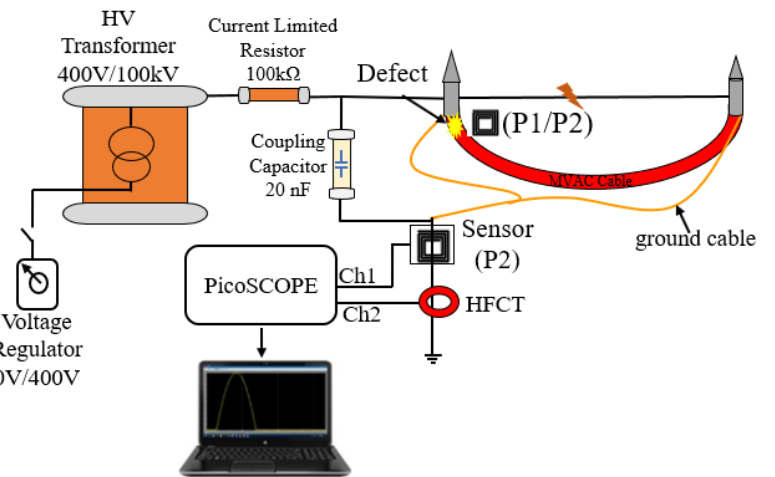
Figure 6. Equivalent electrical connection circuit of the setup.